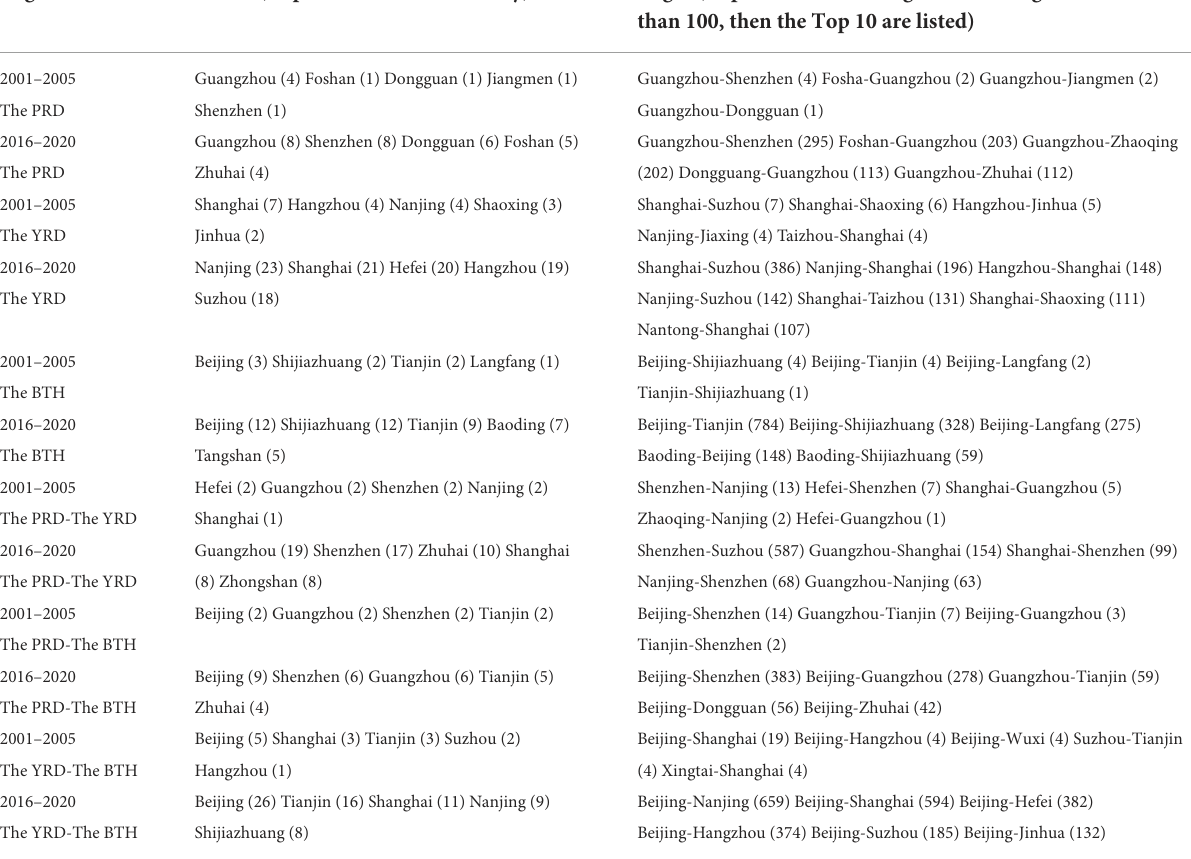
TABLE 6 Spatial pattern of Chinese urban biomedicine innovation networks on the interregional scale in the 2016–2020 period. Region Nodes (Top 5 in terms of centrality) Edges (Top 5 in terms of weight. If the weights are more than 100, then the Top 10 are